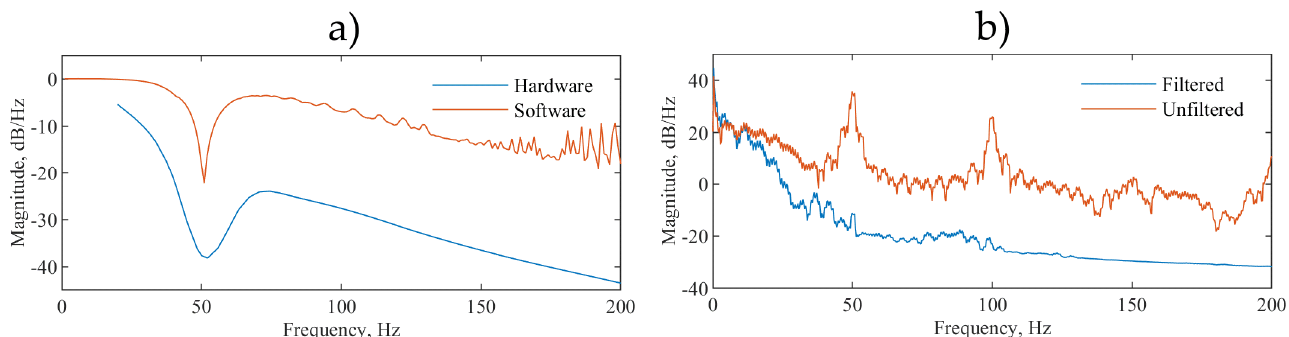
Figure 7. ( a ) Frequency response analysis of hardware and software stages, ( b ) power spectral density showing the combined effect of hardware and software filtering on a noisy test ECG signal injected directly into the front end.